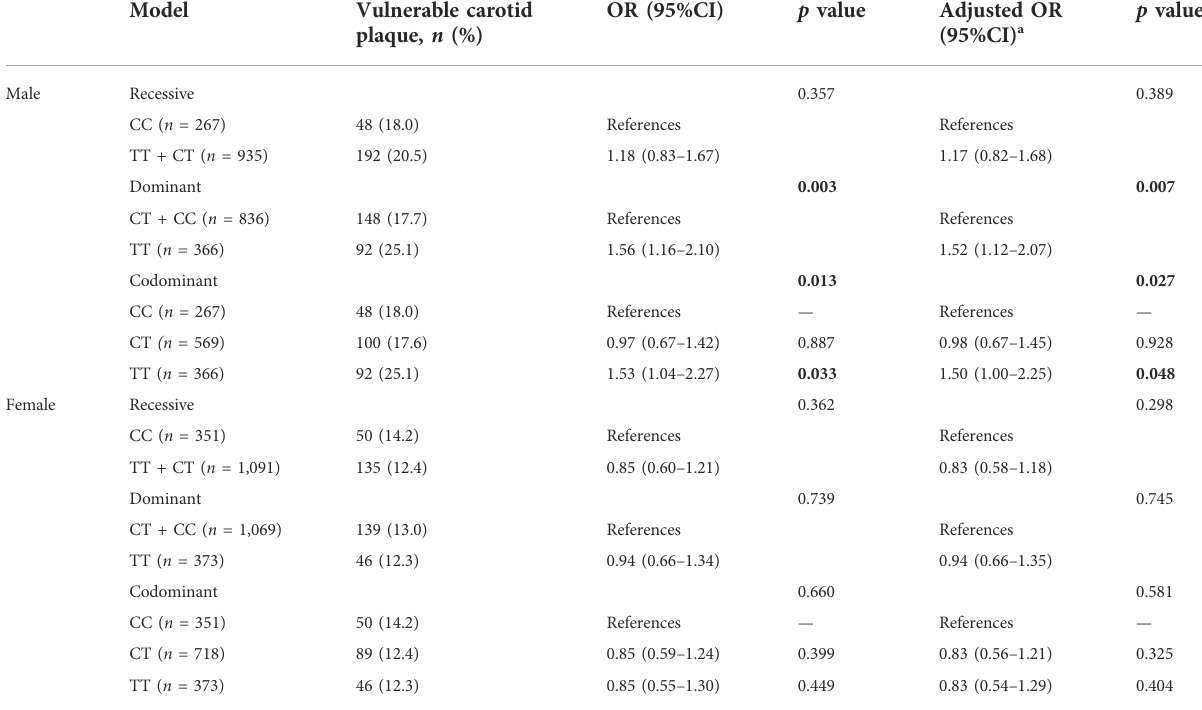
TABLE 5 Sex-speci fi c genotypic association of IL6R rs4845625 with vulnerable carotid plaque in different genetic models.